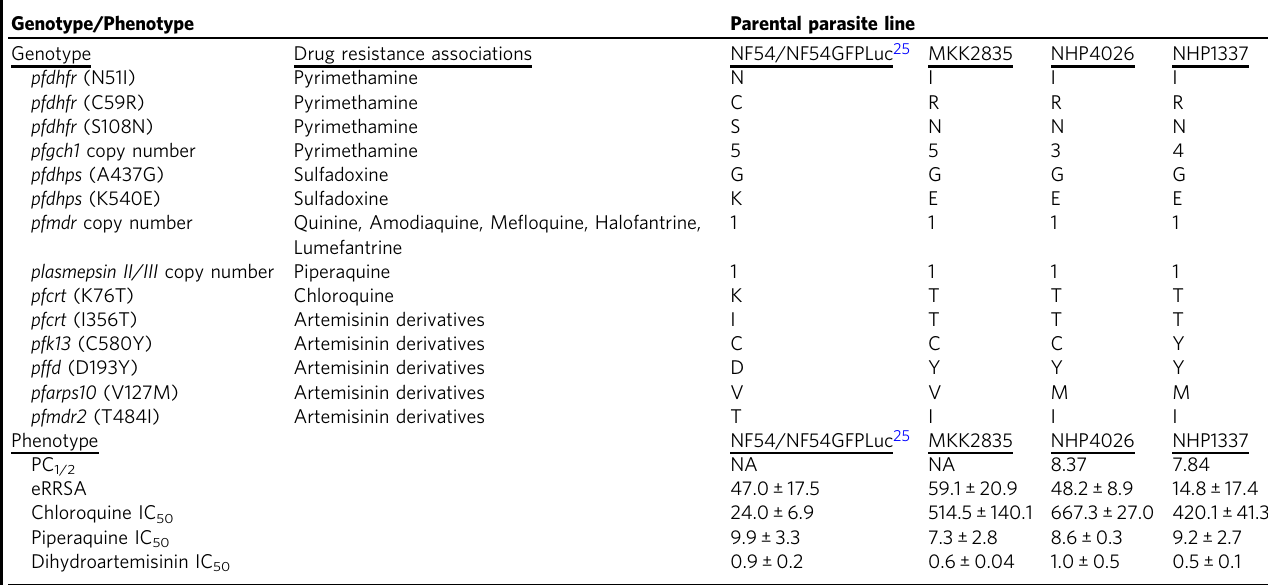
Table 1 Drug resistance related genotype information and drug phenotype information for parents. Genotype/Phenotype